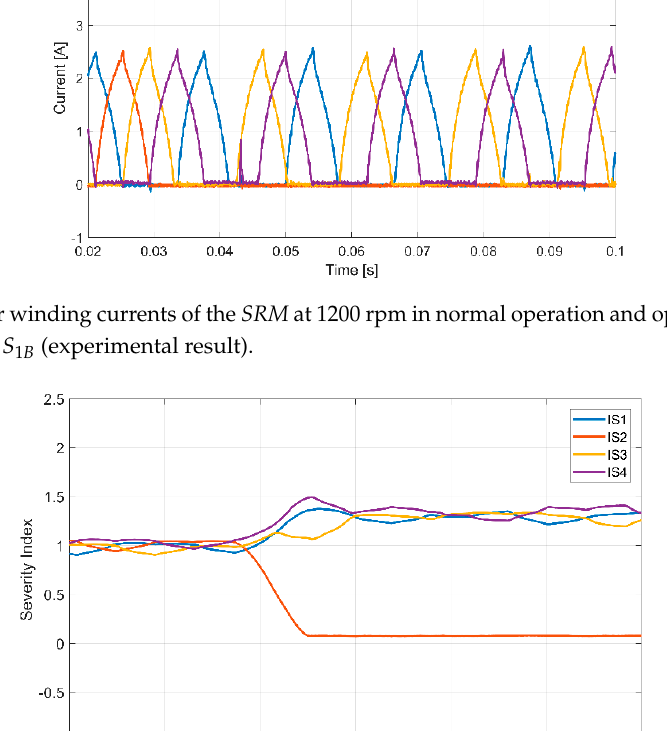
Figure 21. Diagnostic variables associated with the motor winding currents of the SRM at 1200 rpm in normal operation and open-circuit failure of power device S 1 B (experimental